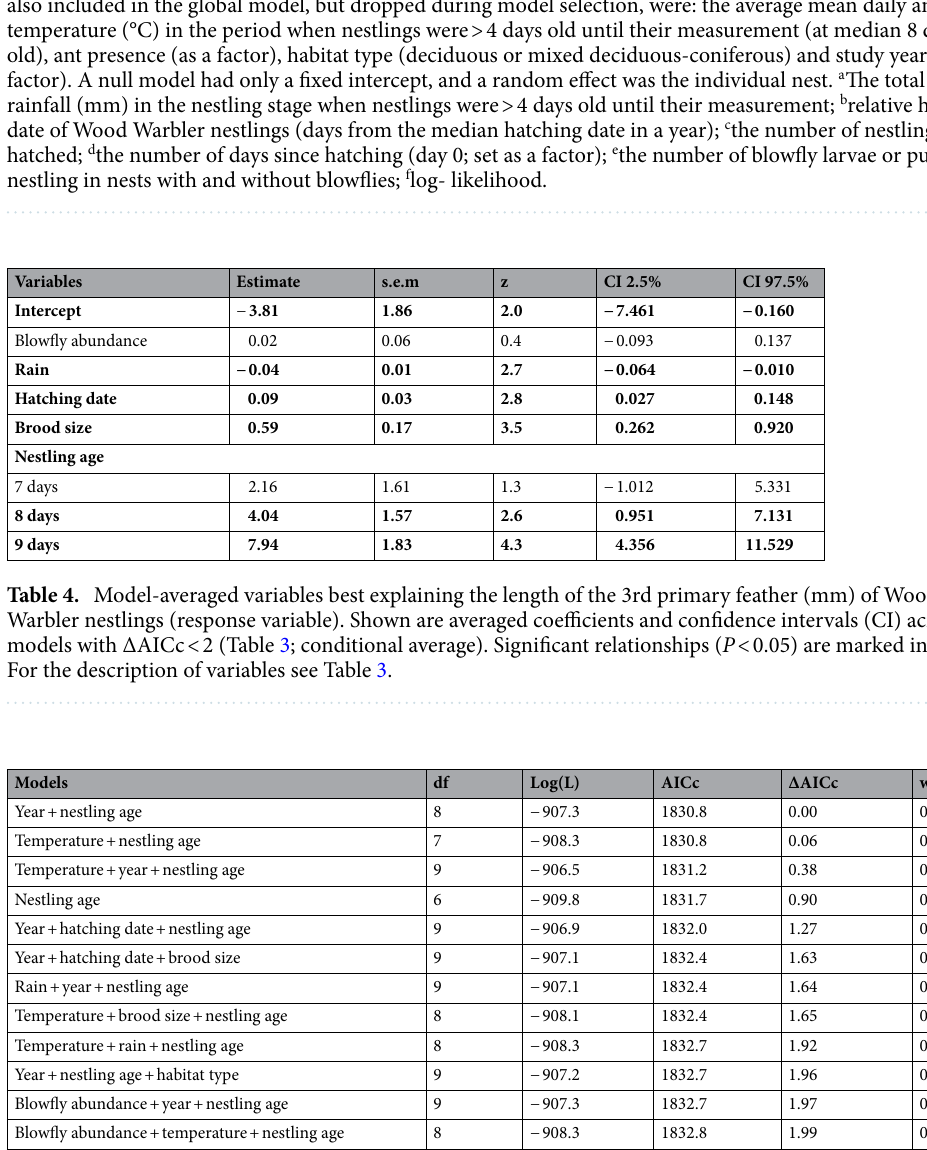
Table 5. Selection of linear mixed effect models (ΔAICc < 2) best explaining the variation in body mass (g) of 742 Wood Warbler nestlings from 129 nests (response variable). The remaining covariate also included in the global model, but dropped during model selection, was ant presence (as a factor). A null model had only a fixed intercept, and a random effect was the nest identity. For the description of covariates see Table 3.